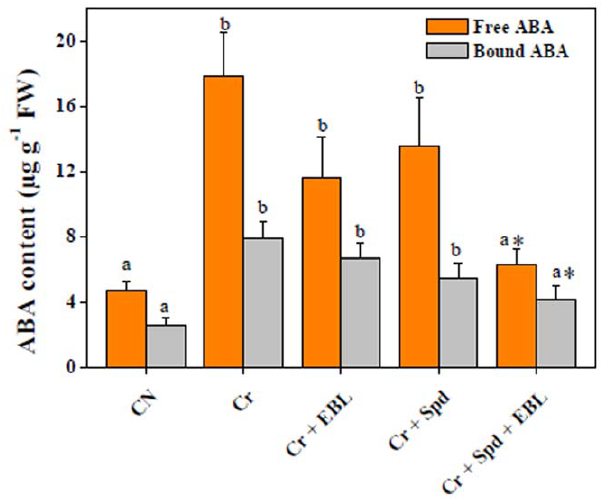
Figure 4. Endogenous levels of free and bound ABA ( m g g 2 1 FW) in 7-d-old radish seedlings under Cr-stress without or with EBL and/or Spd. Data are presented as mean 6 SE. Different superscripted letters (a, b) indicate significant difference from each other in all combinations (Tukey’s test, p , 0.05). Asterisk ‘‘*’’indicates significant difference for EBL + Spd vs. EBL under Cr-stress (Tukey’s test, p , 0.05).